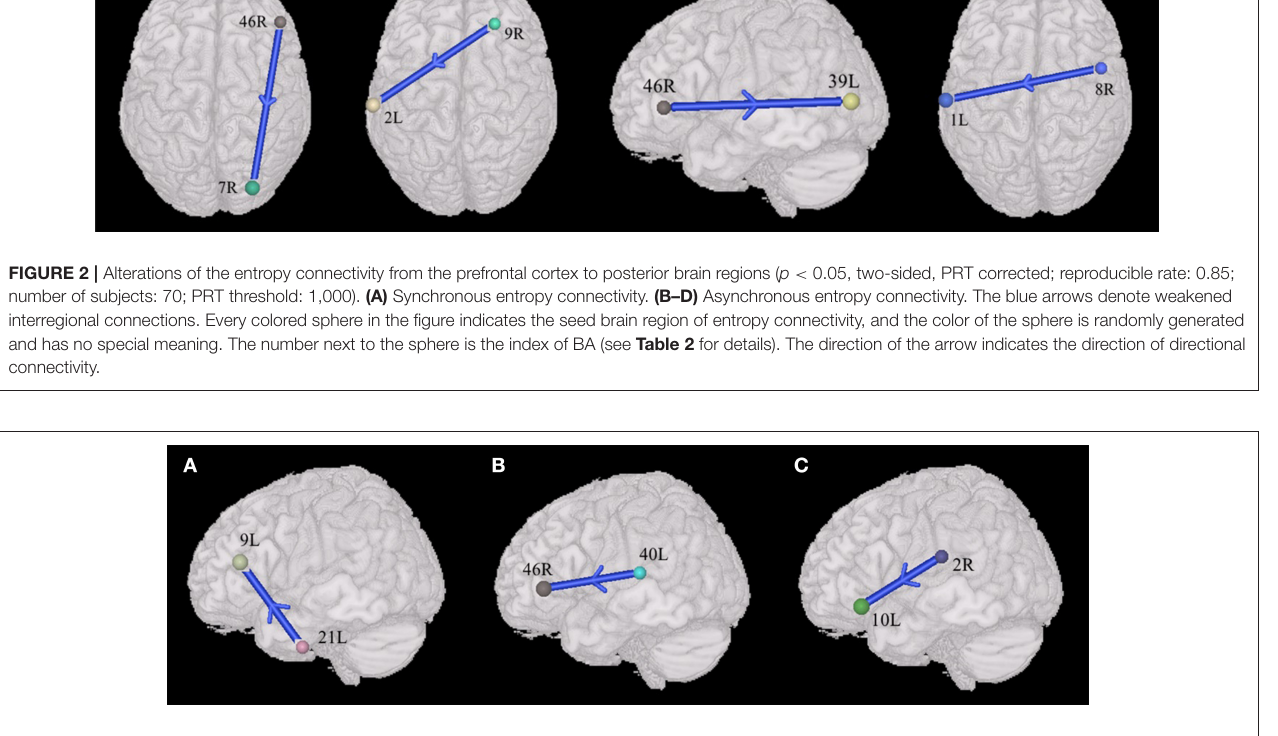
FIGURE 3 | Alterations of the entropy connectivity from the posterior brain regions to prefrontal cortex ( p < 0.05, two-sided, PRT corrected; reproducible rate: 0.85; number of subjects: 70; PRT threshold: 1000). (A,B) Synchronous entropy connectivity. (C) Asynchronous entropy connectivity. The blue arrows denote weakened interregional connections. Every colored sphere in the figure indicates the seed brain region of entropy connectivity, and the color of the sphere is randomly generated and has no special meaning. The number next to the sphere is the index of BA (see Table 2 for details). The direction of the arrow indicates the direction of directional